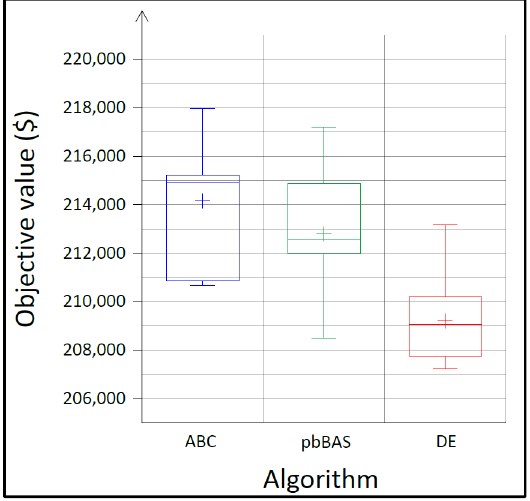
Figure 21. Box plot of the results achieved by each metaheuristic algorithm after 10 runs for the three-segment type folded plate roof problem.